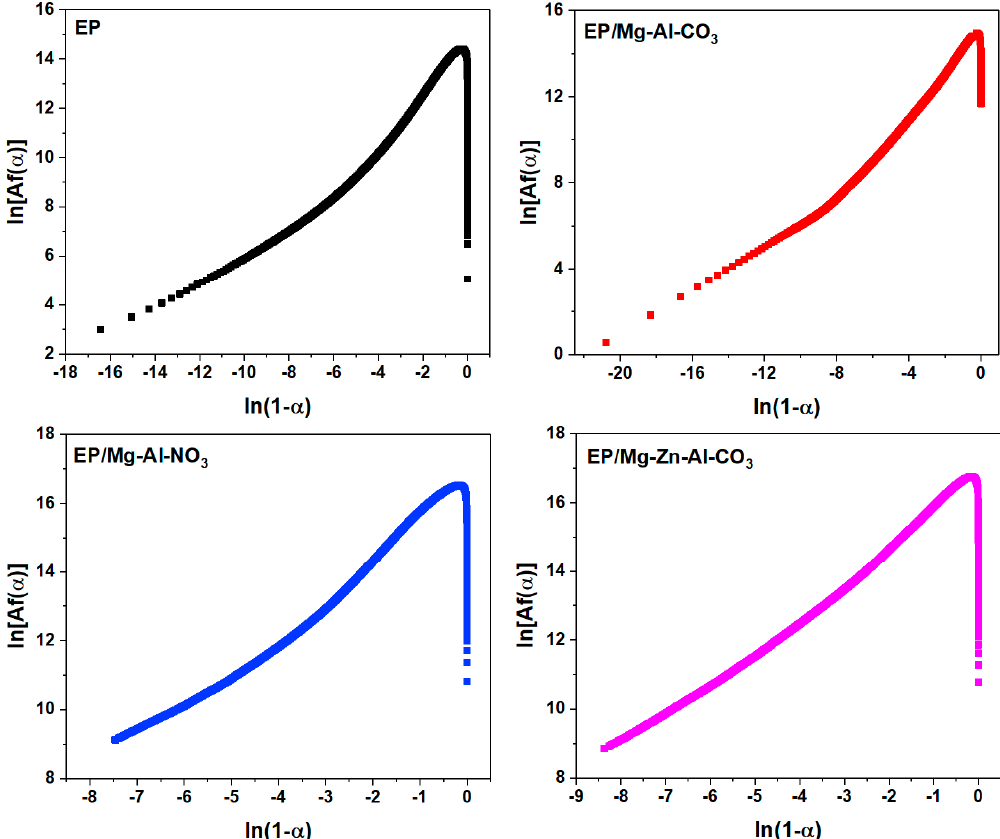
Figure A3. Plots of ln [Af( α )] vs. ln(1 − α ) for the samples under a heating rate of 2 °C ∙ min − 1 used in the calculation of activation energy via the Friedman method.